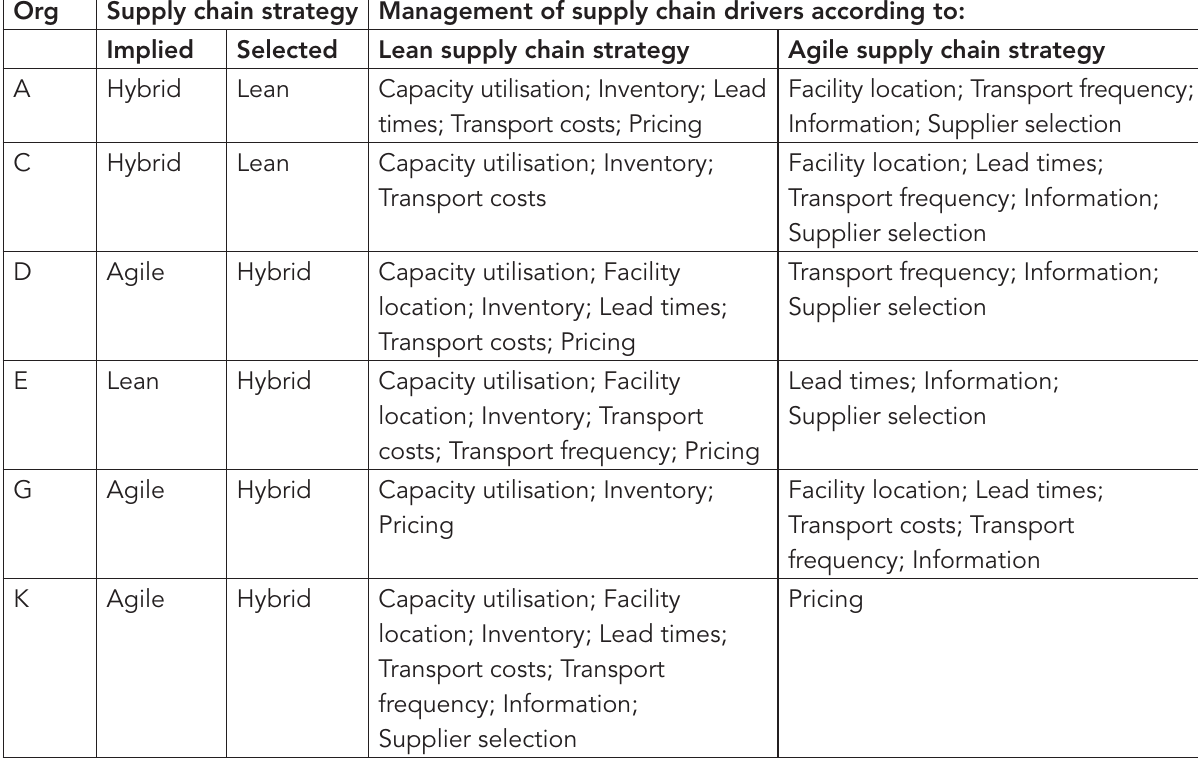
Table 5: Management of supply chain